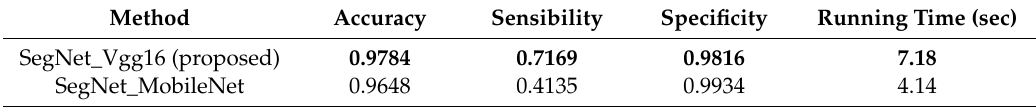
Table 6. Performance comparison for the vessel segmentation using own dataset.